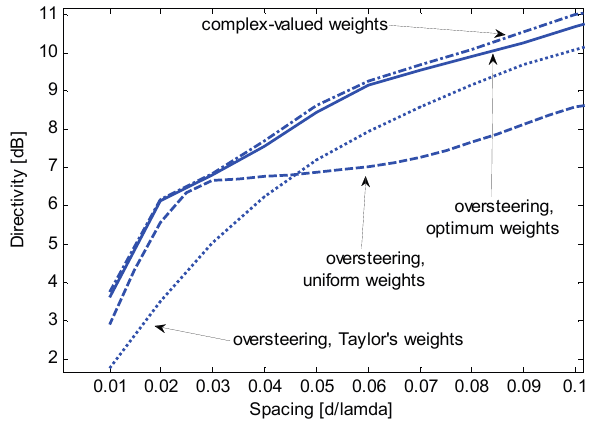
Figure 7. Magnification of a section from Figure 6.